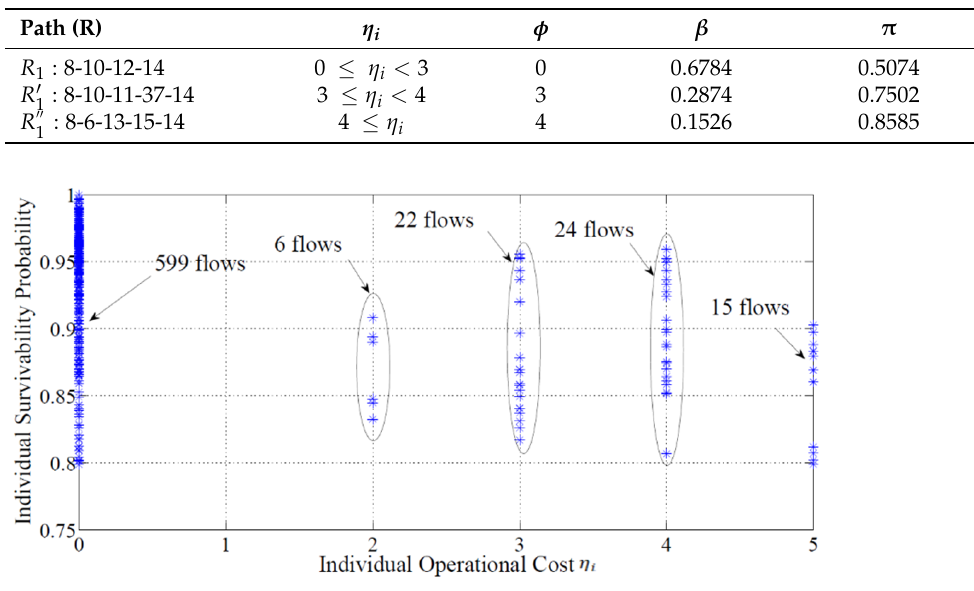
Figure 3. Number of rerouted flows, their survivability probabilities, and individual operational cost in the solution of P2 for η =